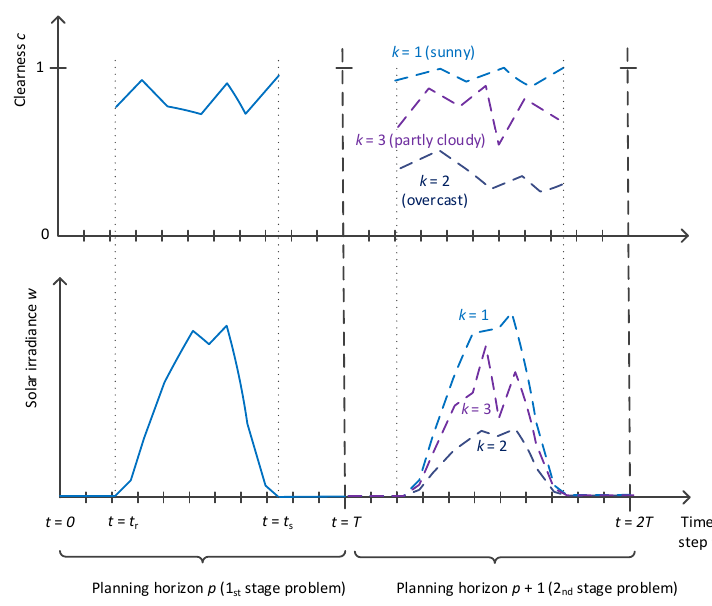
Figure 3. Schematic illustration of the model of stochasticity in clearness (above) and solar irradiance (below) beyond the planning horizon 𝑡 = 𝑇 .